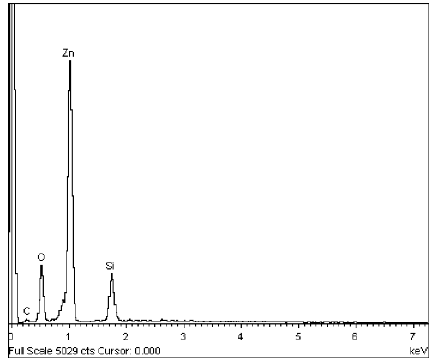
Figure 2. A typical EDX spectrum of as-synthesized ZnO at 500 °C.